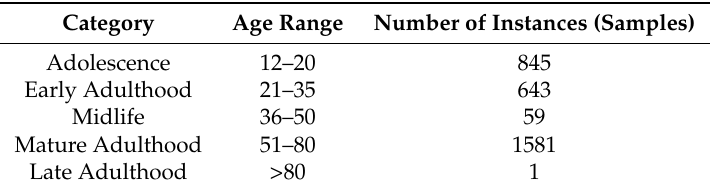
Table 4. Age mapping rules and number of instances in each